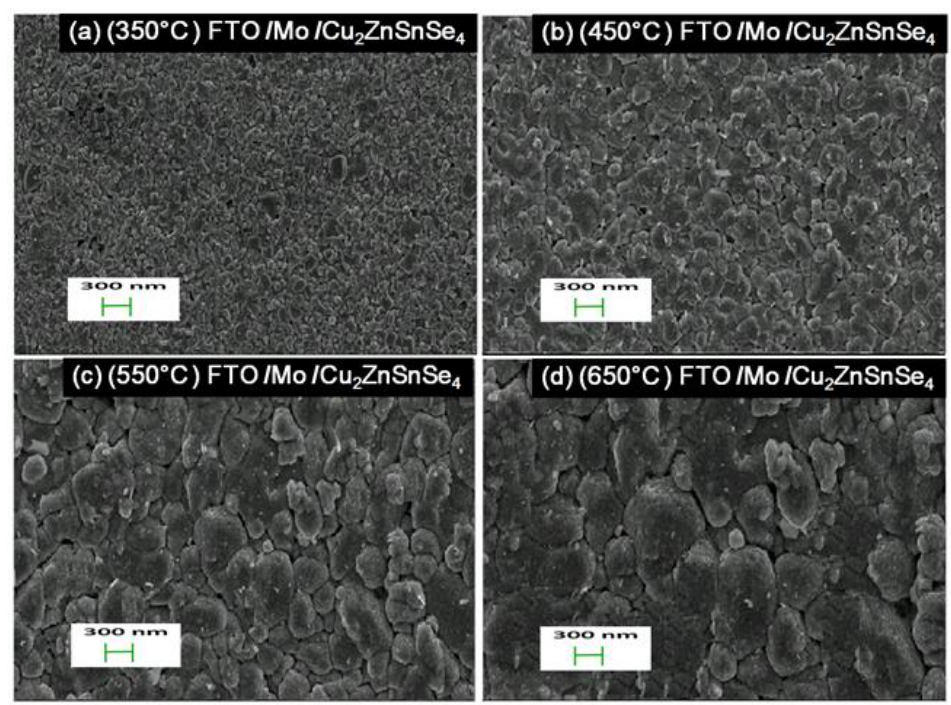
Figure 4. Top-view SEM micrographs of theCu 2 ZnSnSe 4 HTM layers after the various annealing temperatures of: ( a ) 350 °C; ( b ) 450 °C; ( c ) 550 °C; ( d ) 650 °C.